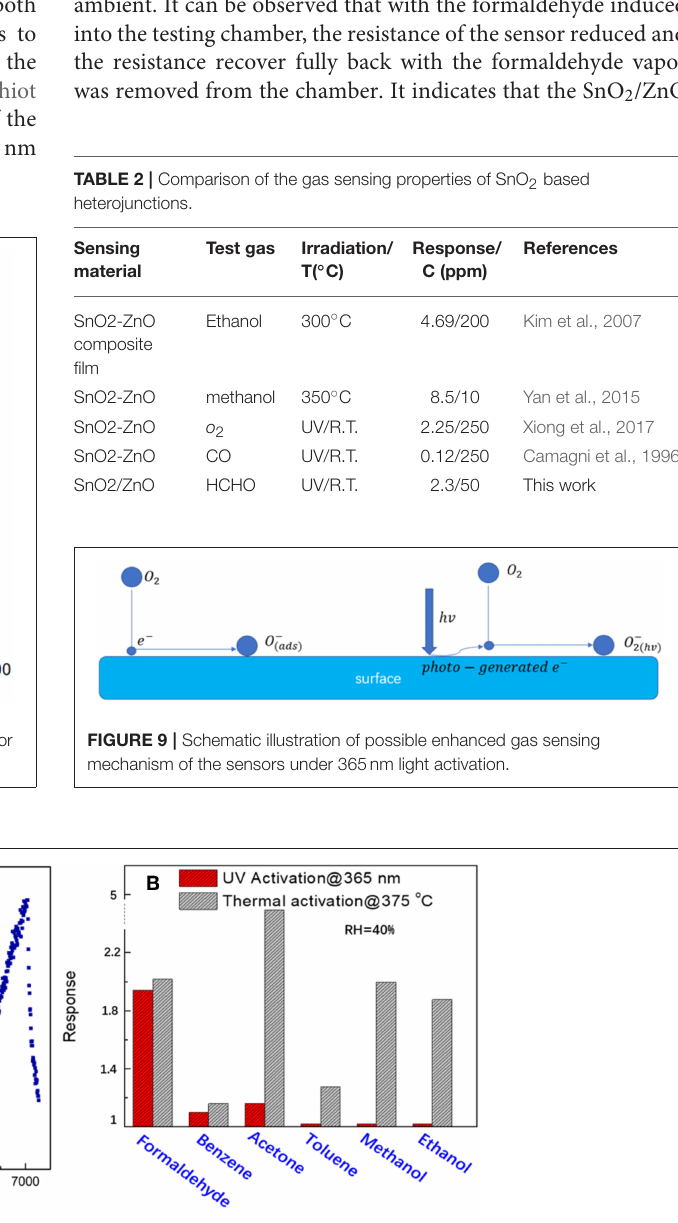
FIGURE 8 | (A) Signal repeatability and (B) comparison of the response of the SnO 2 /ZnO heterojunction based sensor to formaldehyde with other several possible interference such as benzene, acetone, toluene, methanol and ethanol with 50 ppm each under the 365nm light illumination and with the humidity of RH = 40%.